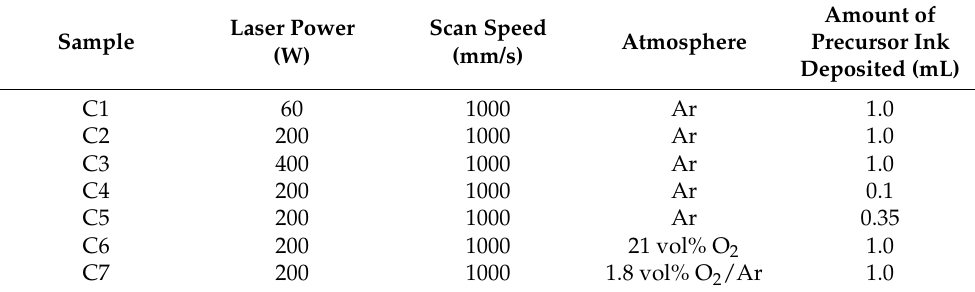
Figure 1. Schematics of experimental setup ( a ) precursor deposition setup; ( b ) precursor deposited substrate placed in a conventional furnace; ( c ) laser canister setup used in this work. Table 1. Manufacturing conditions.